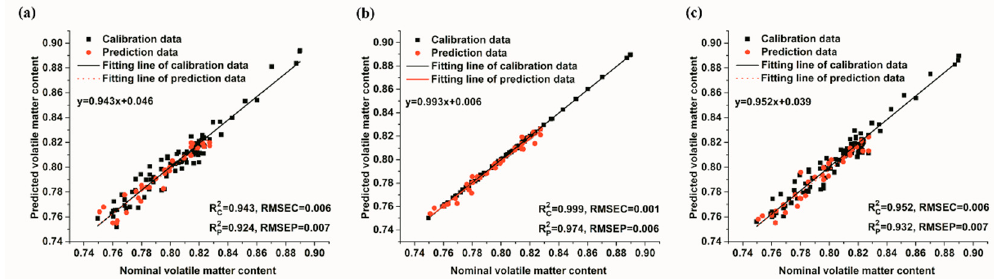
Figure 5. Model fitting results for VM. ( a ) PLSR (partial least-squares regression); ( b ) LS-SVM (the least-squares support vector machine); ( c ) ELM (extreme learning machine).